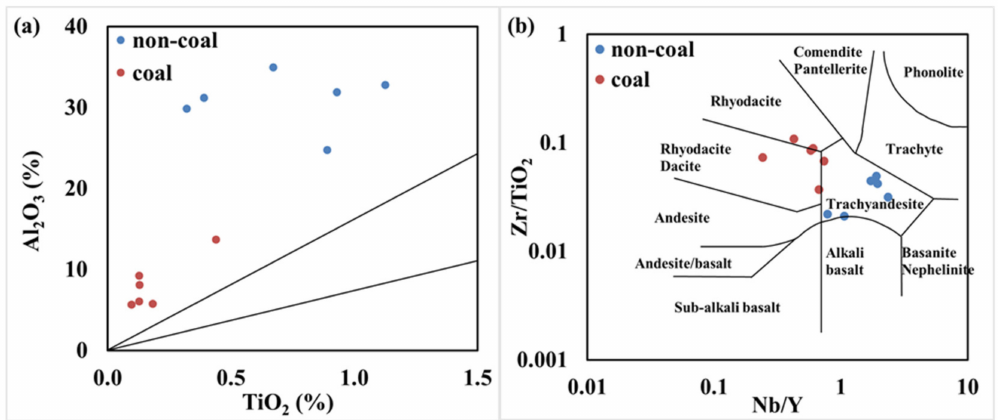
Figure 8. Figure of relationship between elements in Wujiawan coal. ( a ) Relationship between Al 2 O 3 and TiO 2 . The lower and upper diagonal lines represent Al 2 O 3 / TiO 2 = 8 and Al 2 O 3 / TiO 2 = 21, respectively. ( b ) Figure of the ratio of Zr / TiO 2 verus Nb /